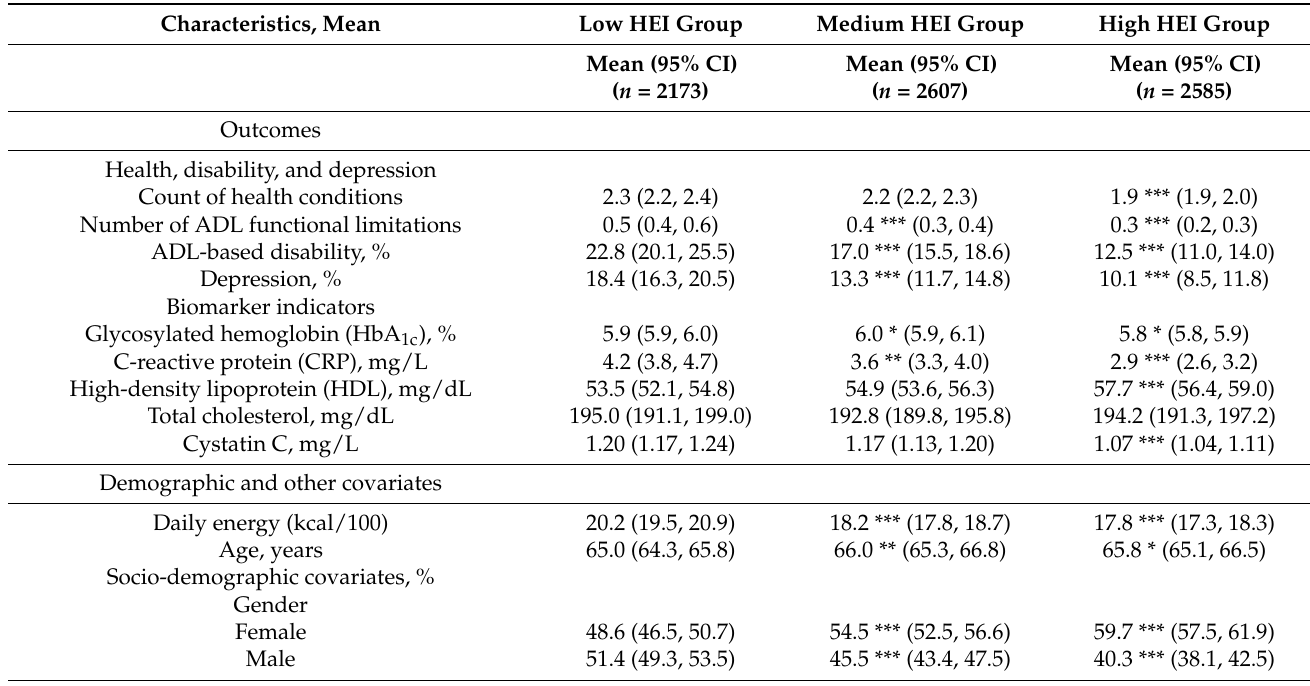
Table 2. Participant characteristics by HEI group/diet